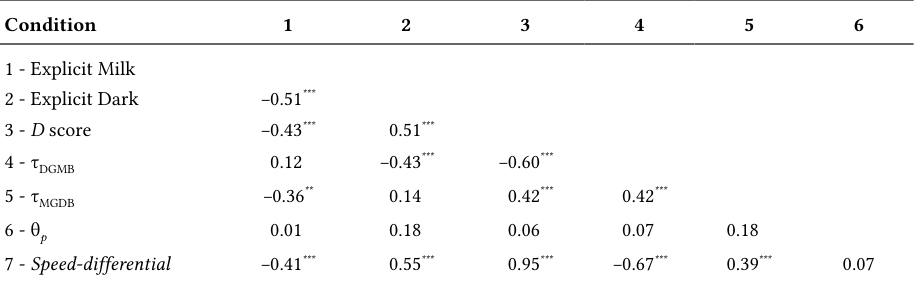
Correlation Between Model Estimates, Explicit Measures, and D Score Condition 1 2